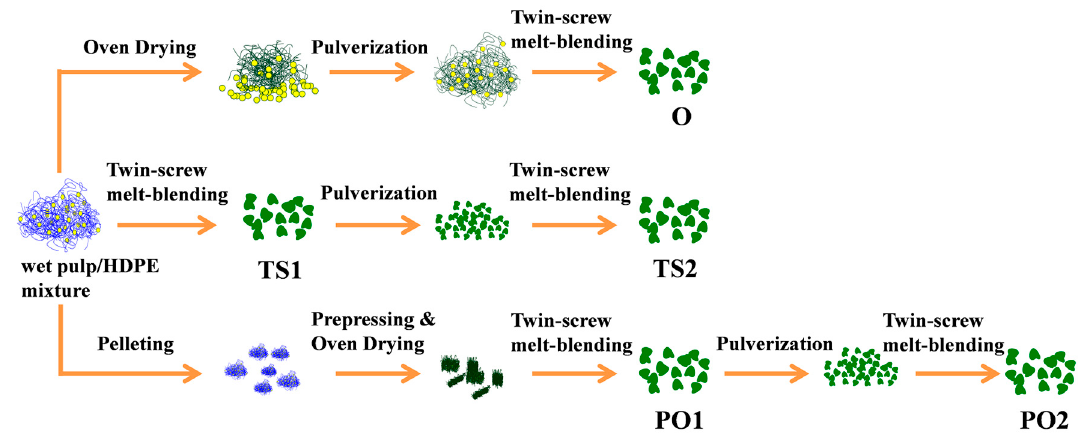
Figure 1. Fabrication processes of pulp fiber/HDPE mixture. Mixture O: wet pulp fiber/HDPE mixture was dried by oven. Mixture TS1: wet pulp fiber/HDPE mixture was dried by twin-screw